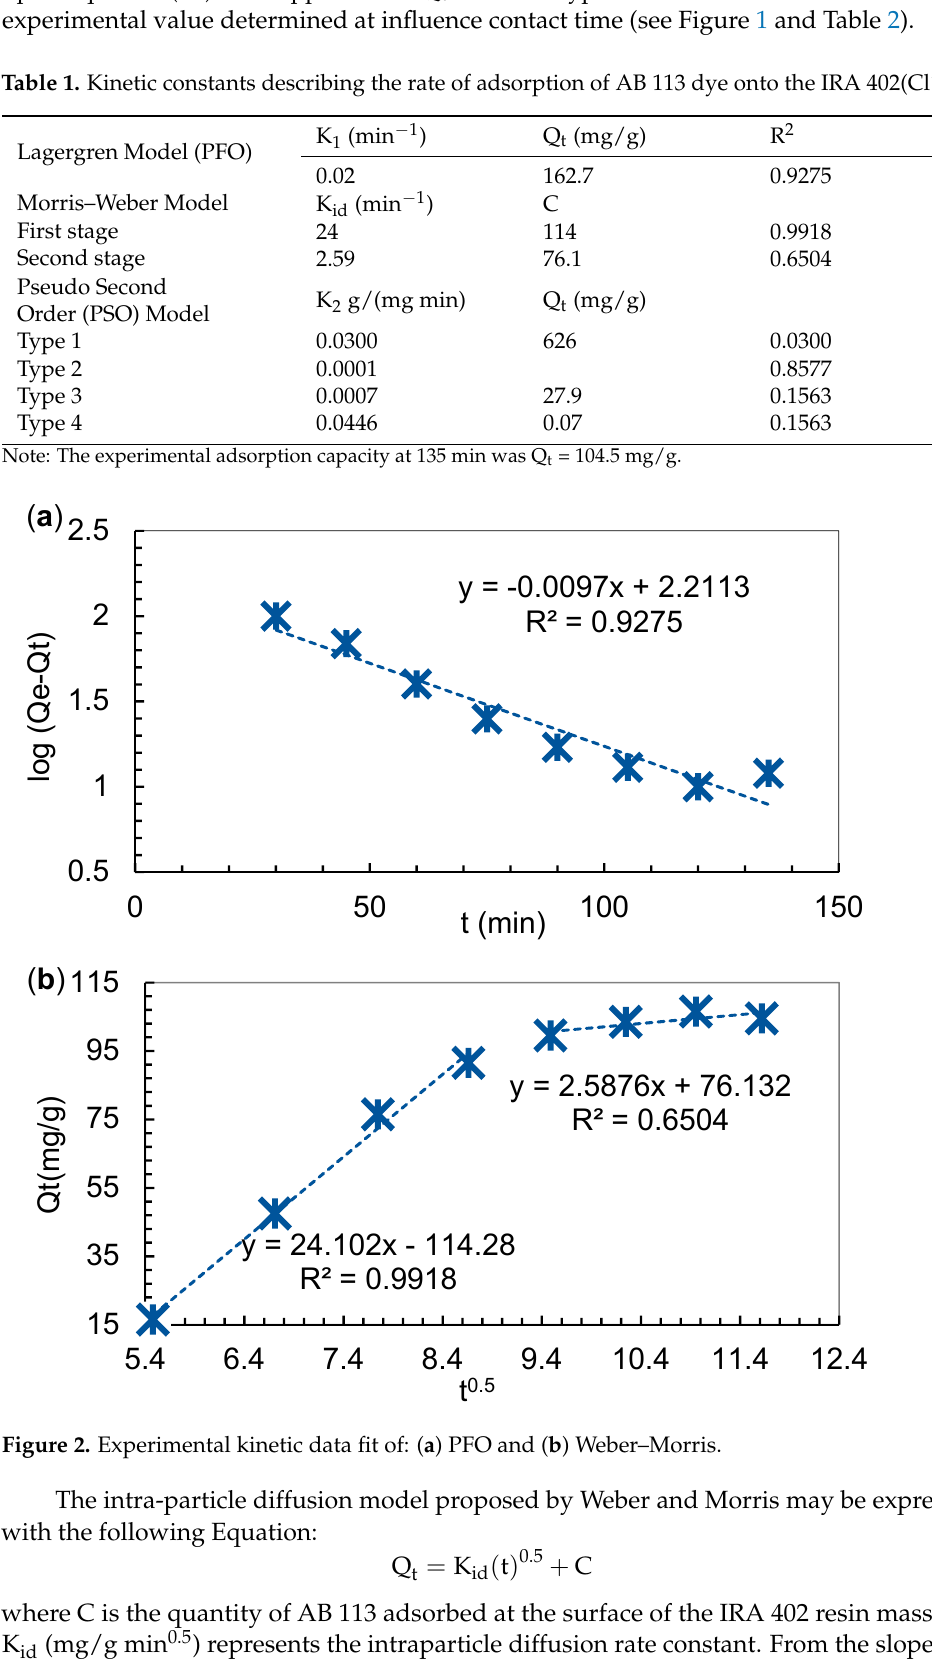
Table 1. Kinetic constants describing the rate of adsorption of AB 113 dye onto the IRA 402(Cl − ).